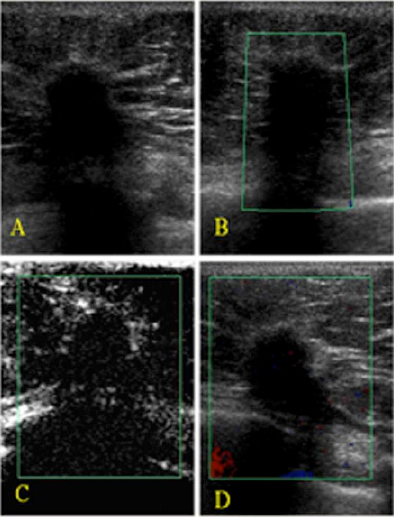
Figure 2 - An invasive ductal carcinoma recurrence in the left breast of a 63-year-old woman. A) A gray-scale image showing an irregular, spiculated mass with an echogenic halo, architec- tural distortion, acoustic shadowing, and straightening of Cooper’s ligament (BI-RADS 5). B) A color Doppler image showing an avascular lesion. C) After contrast injection, there was minimal enhancement. D) An enhanced color Doppler image showing an avascular lesion.